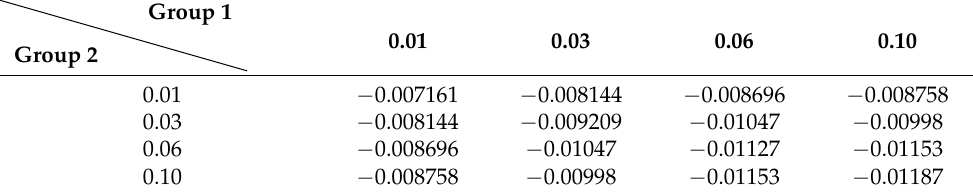
Table A4. Damping coefficient for TM2 of SG under different K p